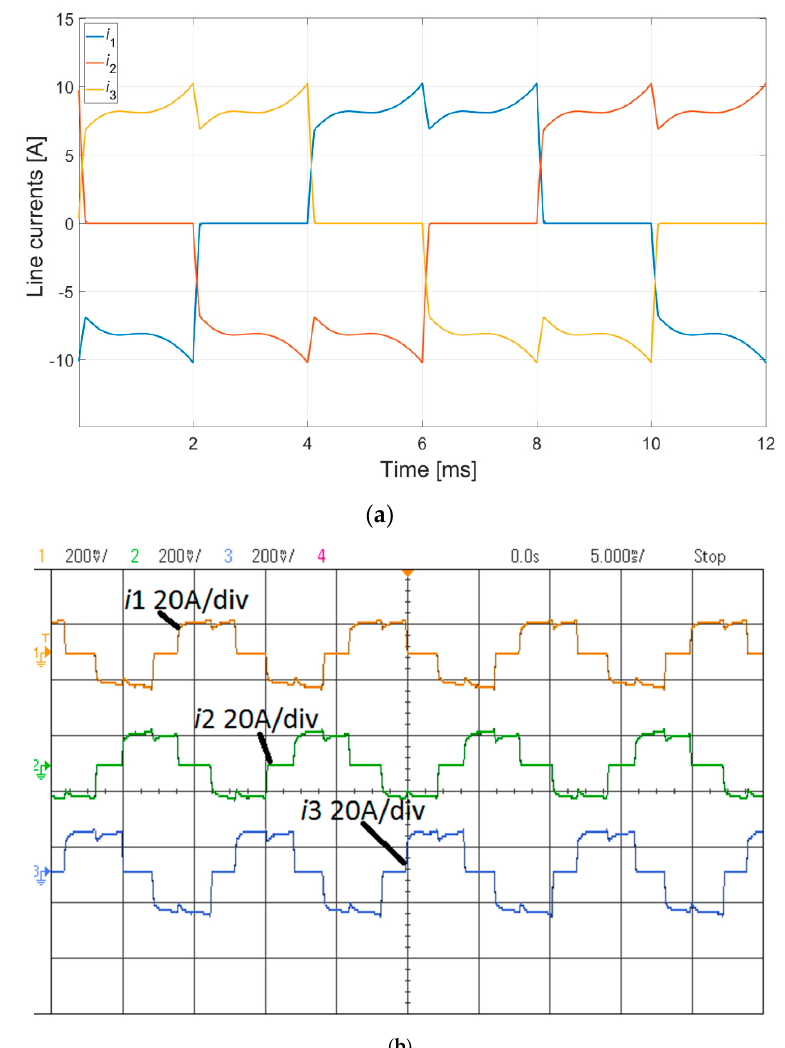
Figure 13. Delta ( ∆ ) configuration—waveforms of line currents in healthy mode: ( a ) numerical Figure 13. Delta ( Δ ) configuration—waveforms of line currents in healthy mode: ( a ) numerical calculations; ( b ) calculations; ( b ) measurements.